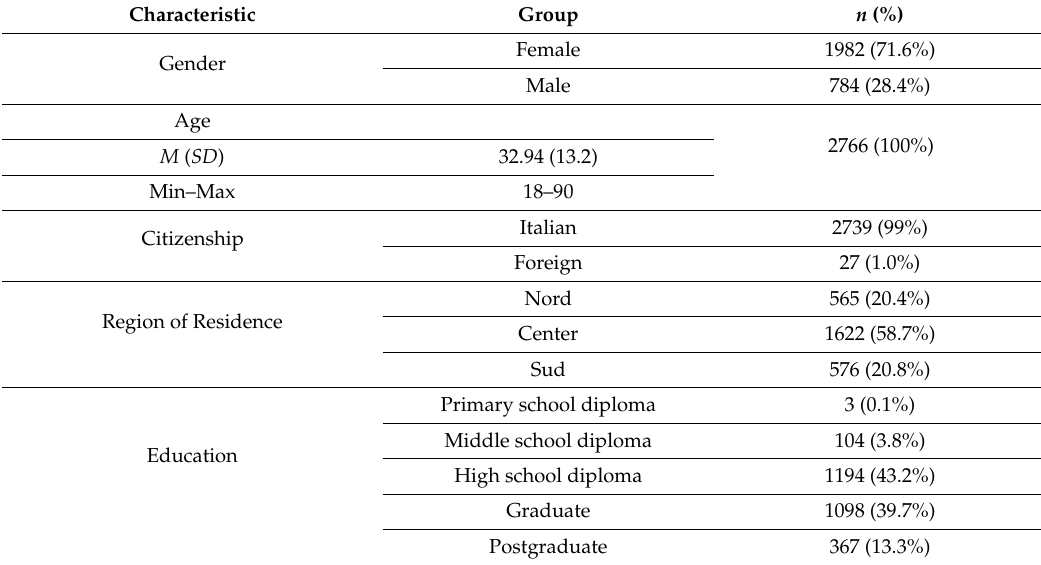
Table 1. Descriptive statistics of the